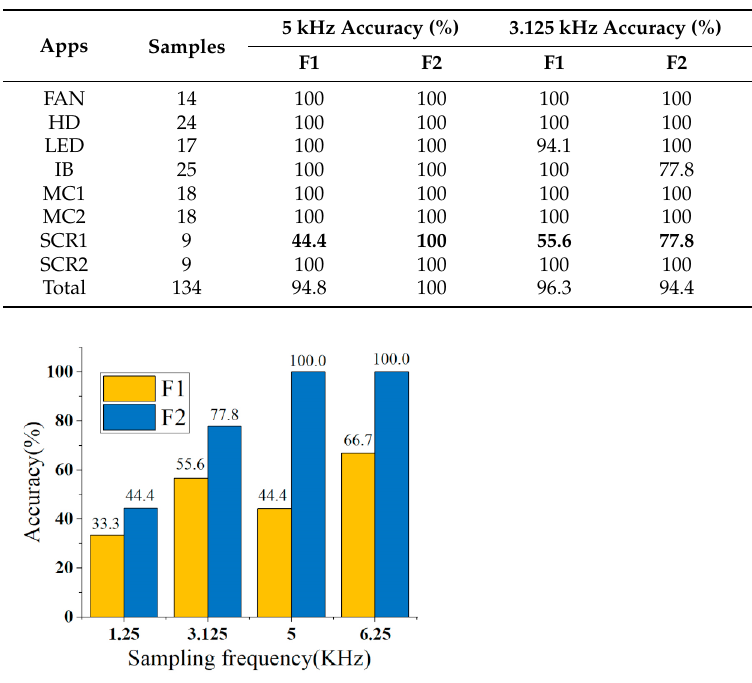
Table 7. Appliance (Apps) identification accuracies (K = 7).